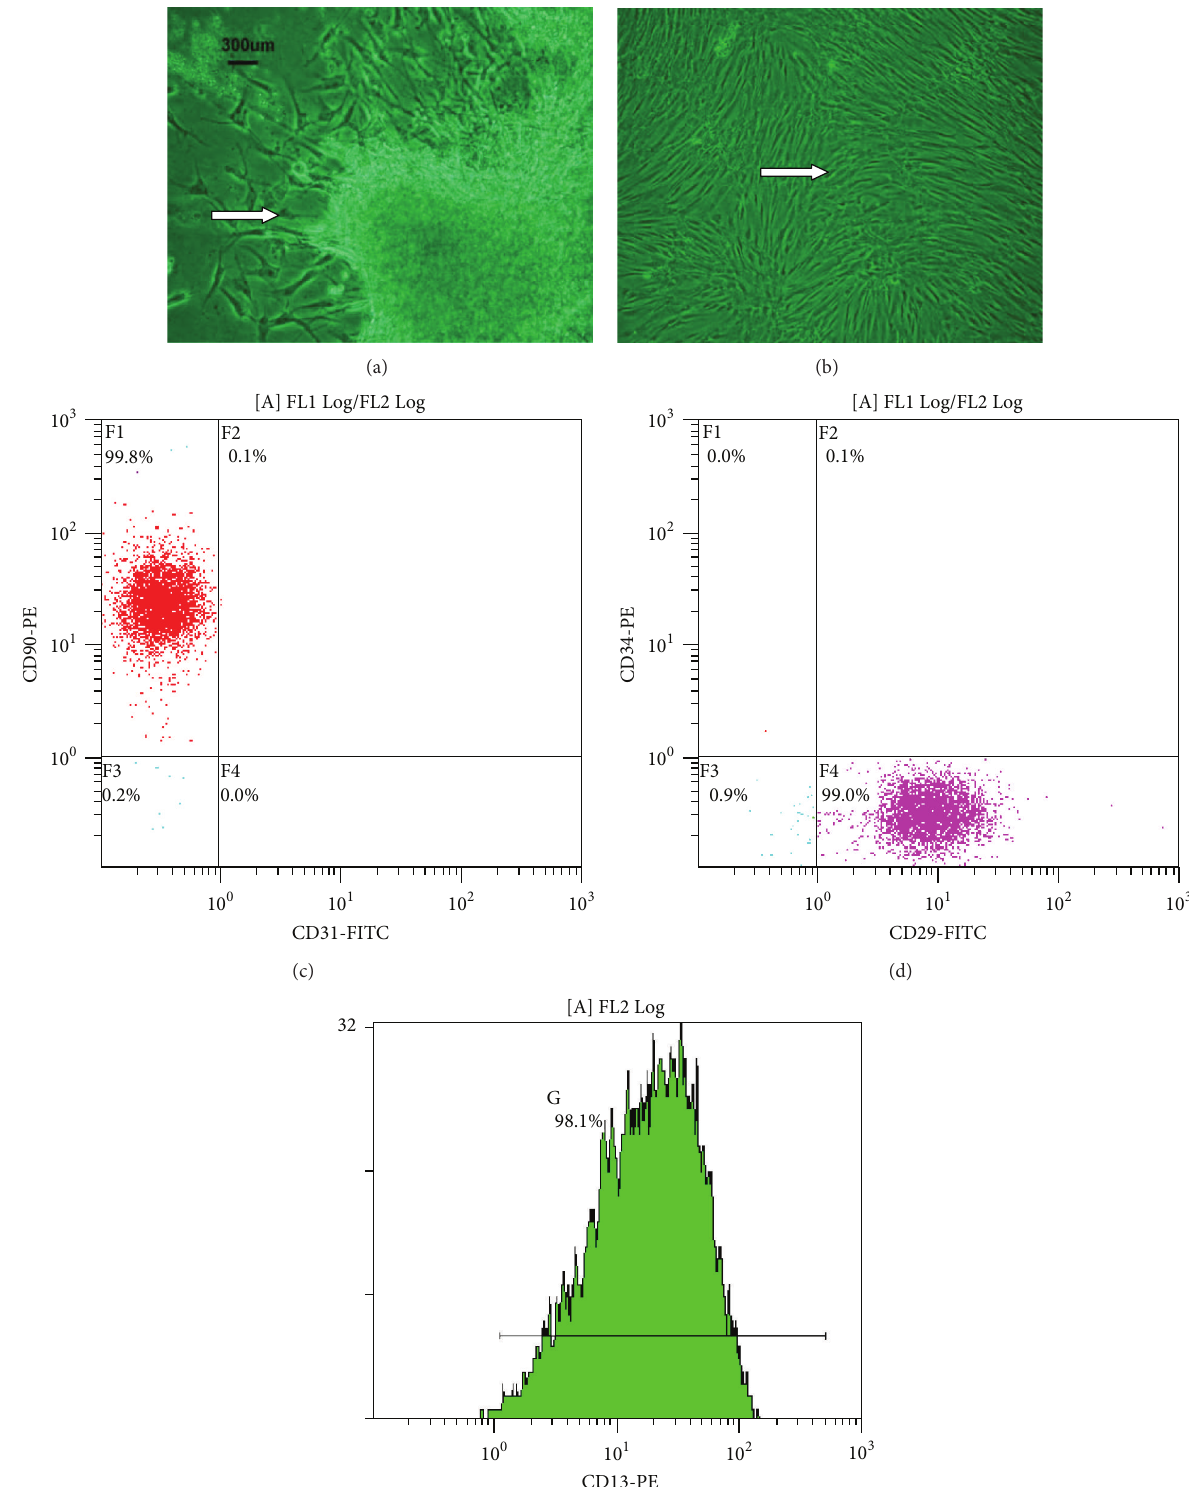
Figure 1: H-UC-MSC morphology. (a) Cells after 7 days in culture. (b) Third passage cells in culture H-UC-MSC flow cytometry results. (c) CD90-PE and CD31-FITC double labeling. (d) CD34-PE and CD29-FITC double labeling. (e) CD13-PE single labeling. The arrows show